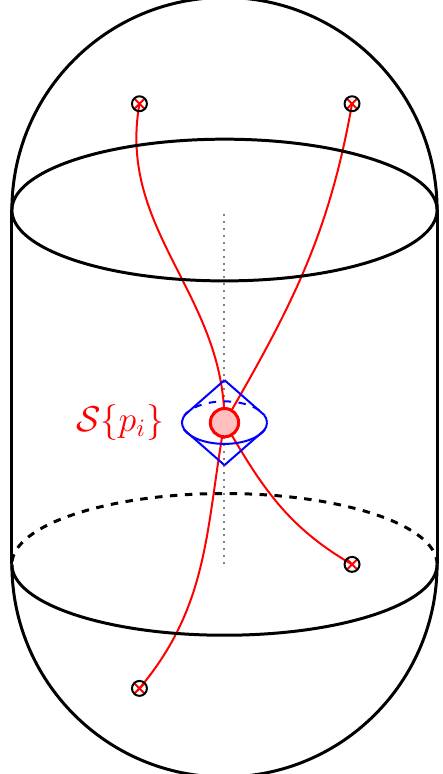
Figure 2. Pictorial representation of the S-matrix according to formula (2.14). We have chosen to represent a 2 ! 2 event where two \in" particles of any mass are created in the scattering region and become two \out" particles after interacting non-trivially in (cid:13)at space. The interaction is represented by a red blob, and its details are encoded in the relevant CFT correlator in the form of a kinematic divergence. The primary operators are located at insertions of the form (2.13), whose complex value has been represented as an insertion in the Euclidean